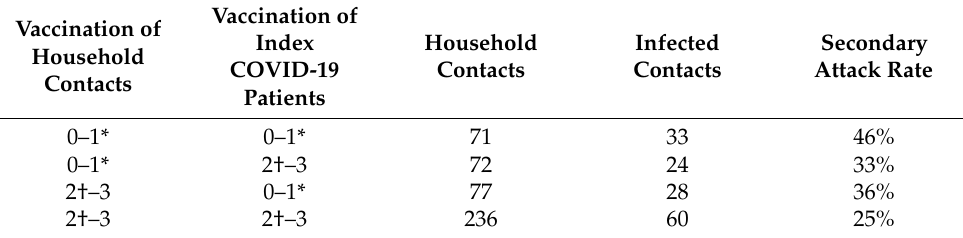
Household Contacts